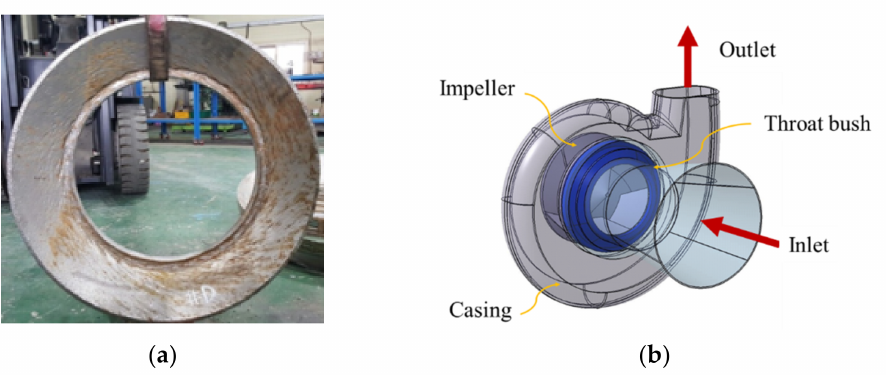
Figure 2. Throat bush and slurry pump: ( a ) erosion by slurry particles; ( b ) boundary conditions for multiphase flow analysis model of the slurry pump with an impeller, throat bush, and casing.